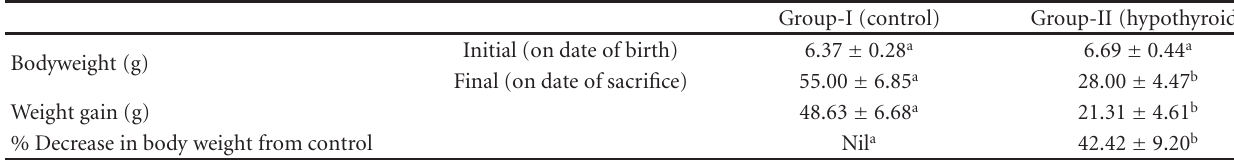
Table 1: E ff ect of neonatal PTU treatment on bodyweight (g) of animals. Data are expressed as mean ± S.D. of 5 observations and subjected to unpaired Student’s t -test. Statistical significance was accepted at P < 0 . 05. Control and hypothyroid groups were found to di ff er significantly at P < 0 . 05 as represented by superscripts of di ff erent letters. Group-I (control): 30-day-old control rats; Group-II (hypothyroid): 30-day-old rats with PTU treatment from day 1 postpartum to day 30 postpartum.